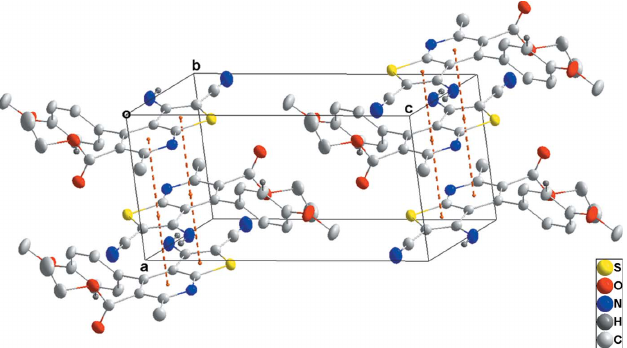
Figure 2 Oblique view of the packing showing two of the (cid:2) – (cid:2) -stacks.